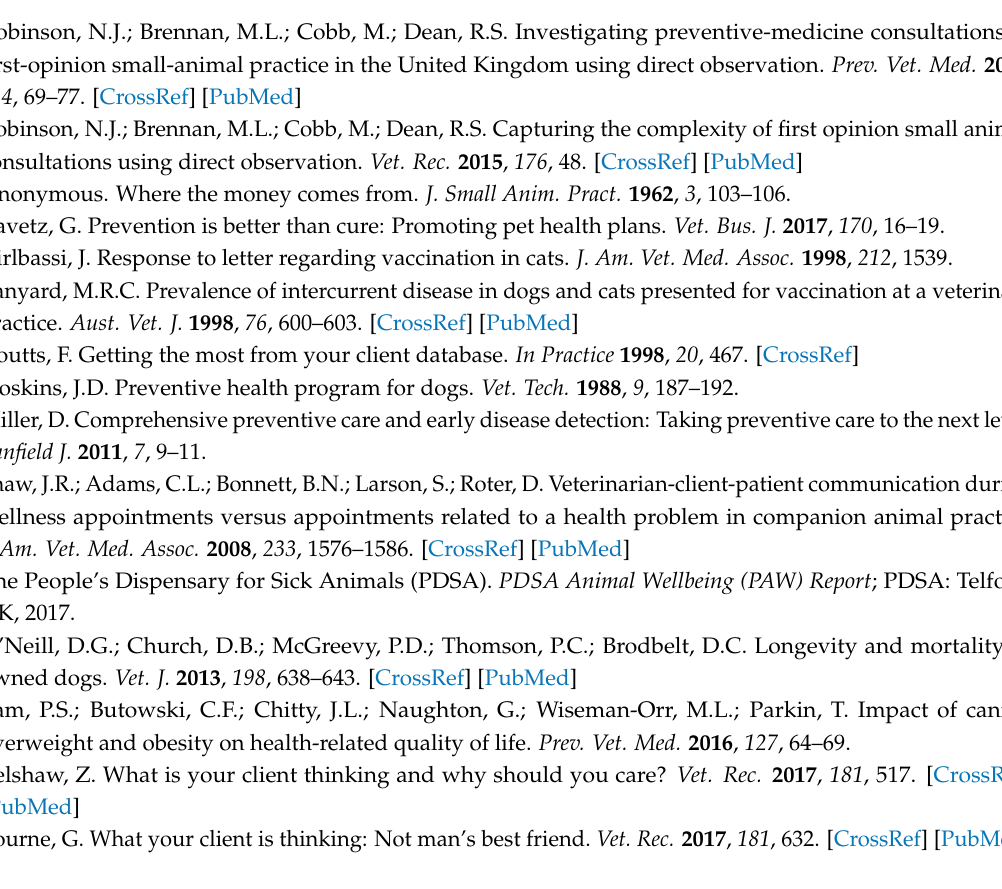
Owner interview guide, Table S2: Veterinary surgeon interview guide, Table S3: Demographic data of owners interviewed, and their pets, Table S4: Demographic data of veterinary surgeons interviewed. Acknowledgments: The Centre for Evidence-based Veterinary Medicine (CEVM) is supported by an unrestricted grant from Elanco Animal Health and The University of Nottingham. The authors received additional financial support from MSD Animal Health for the collection and analysis of these data. The study design, analysis, interpretation of the results, decision to publish and writing of the manuscript were undertaken independently of all funders of the